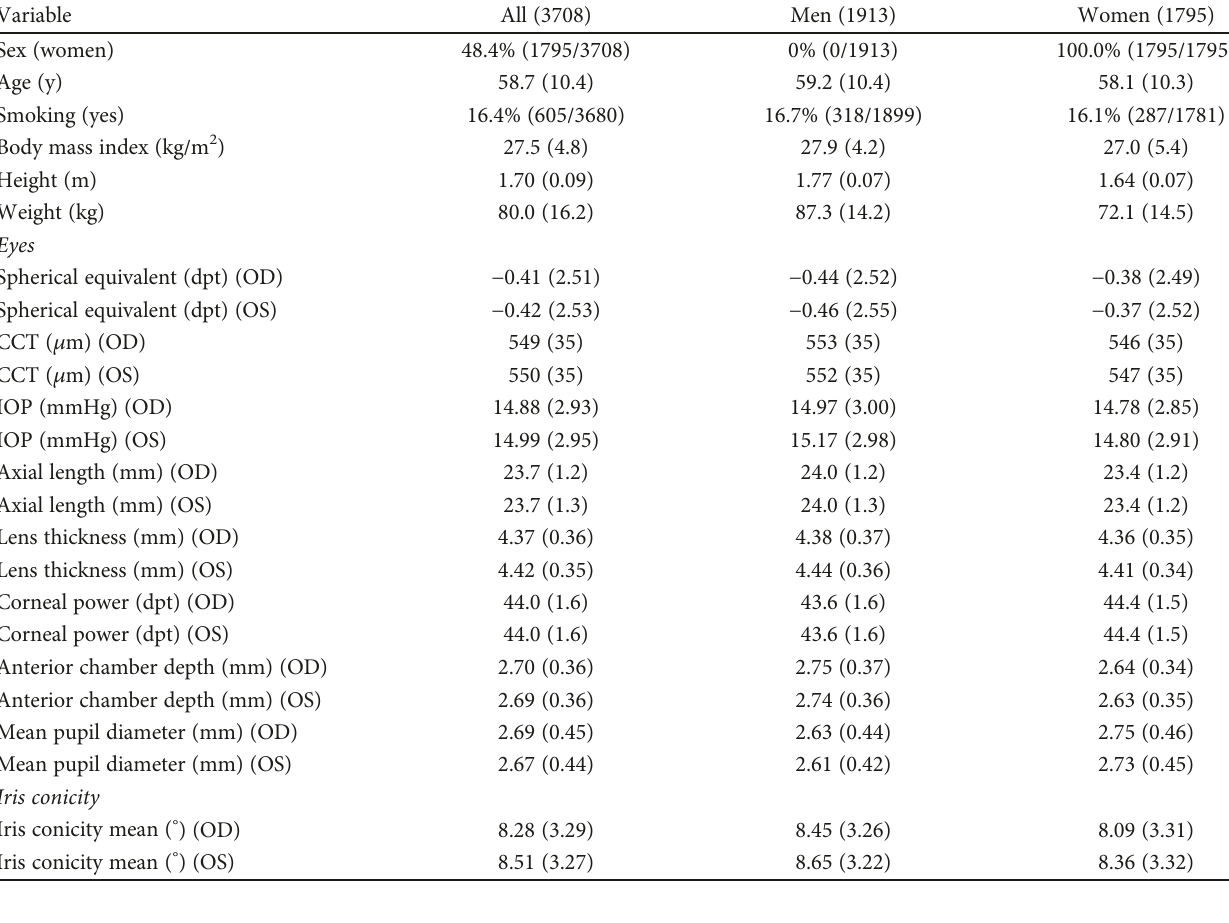
Table 1: Characteristics of the study sample of the Gutenberg Health Study. Means (standard deviations) and proportions in percentage ( n / N ) for dichotomous variables in the total cohort for males and females. CCT: central corneal thickness; IOP: intraocular pressure; OD: right eyes; OS: left